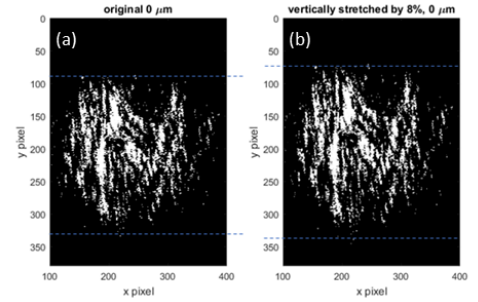
Figure 4. Original image ( a ) and artificially stretched by 8% ( b